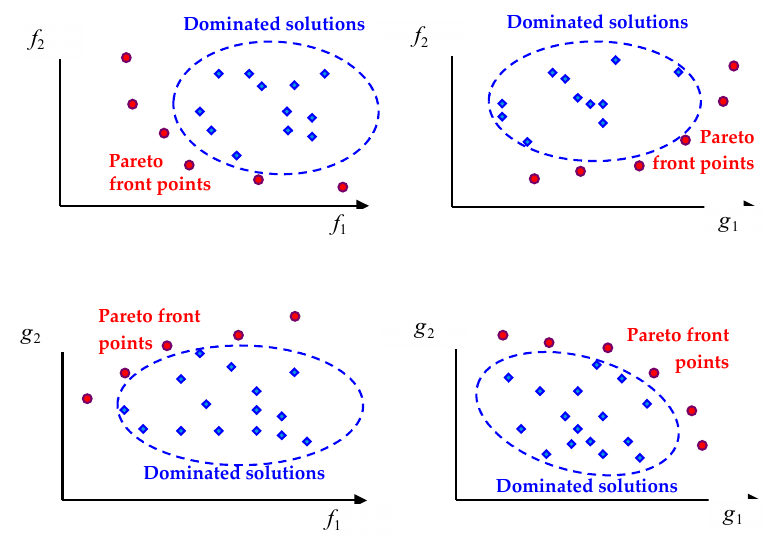
Figure 7. Pareto front points and dominated solutions for objective functions minimized ( f 1 and f 2 ), or maximized ( g 1 and g 2 ).